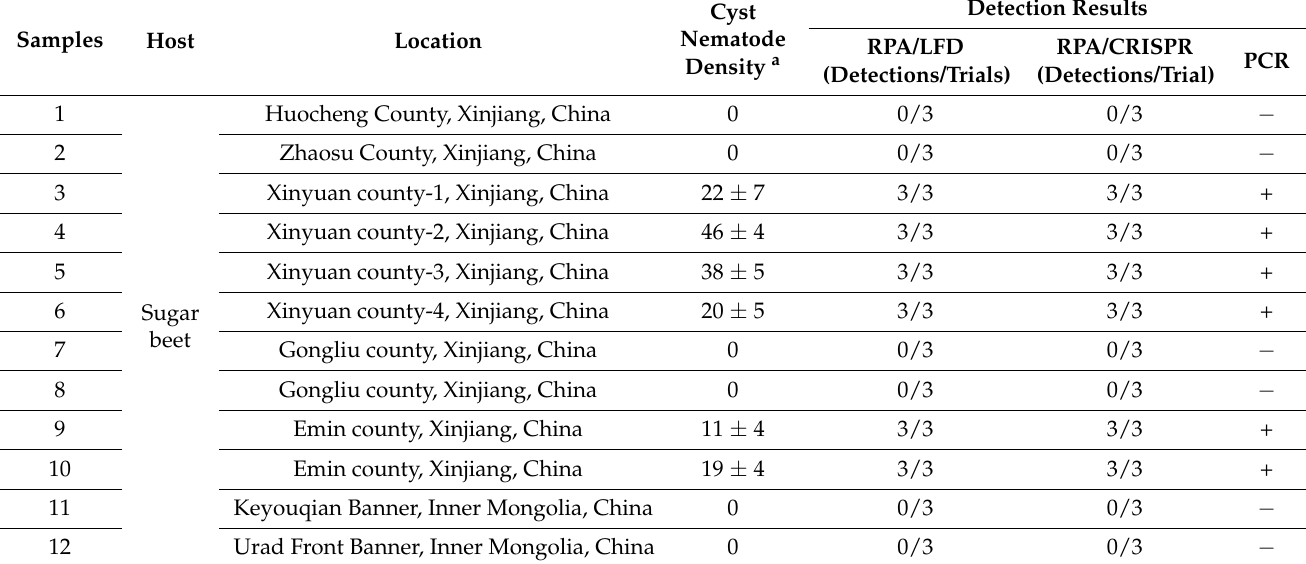
Table 3. Detection of H. schachtii in natural field